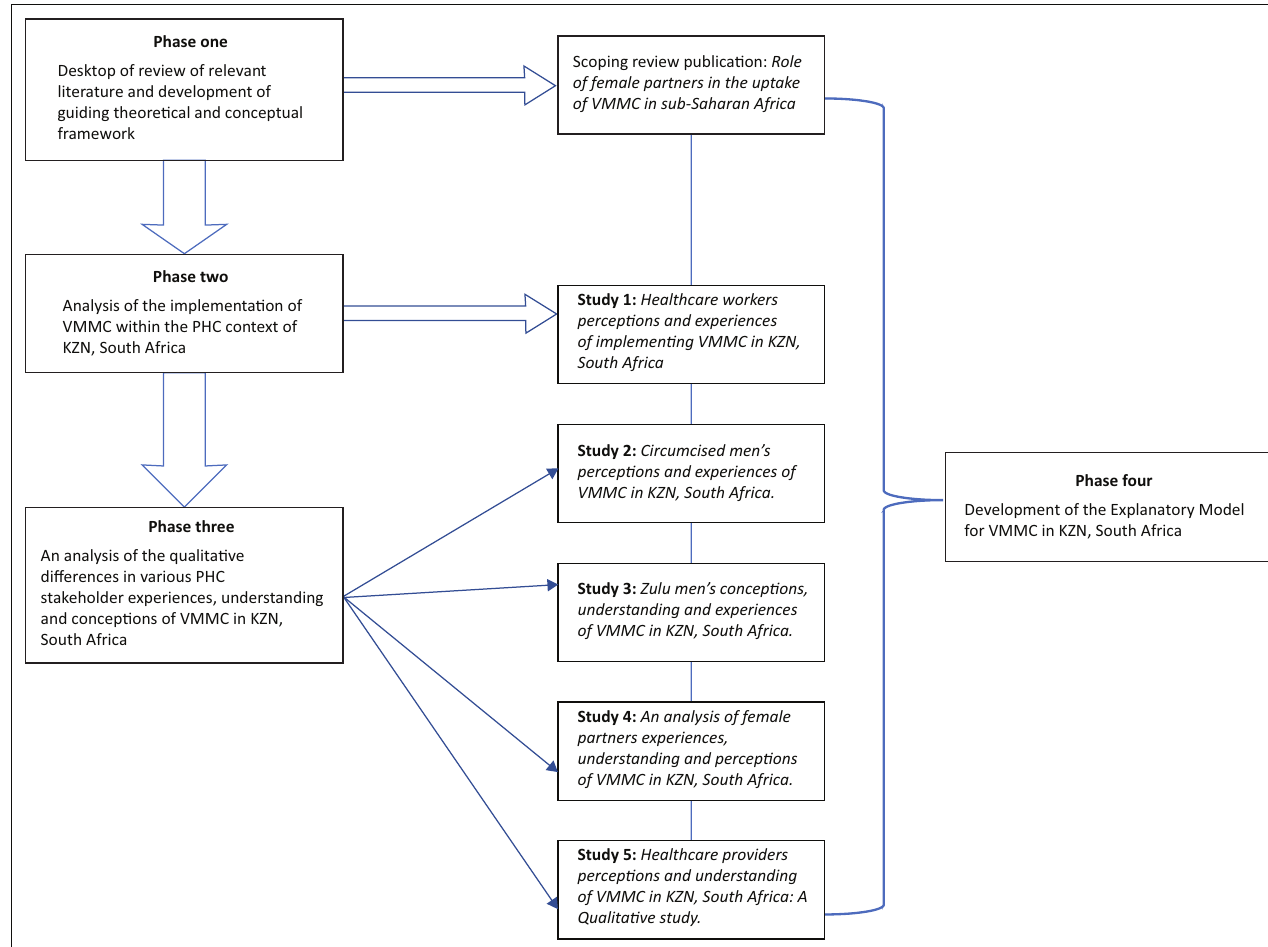
FIGURE 1: Outline of research studies and data generation process informing development of the explanatory model.